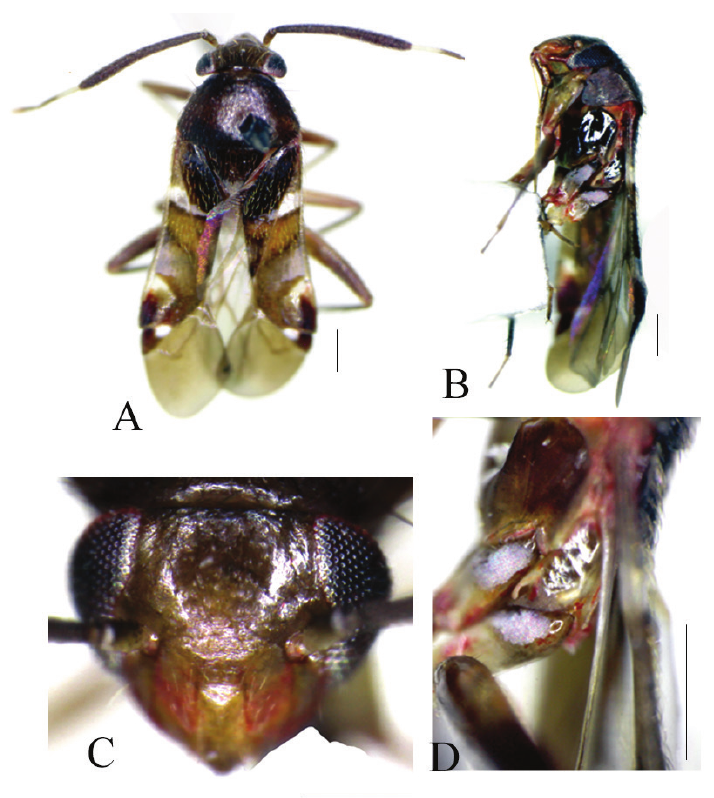
Figure 1. Habitus images of Biromiris tomokunii , holotype male. A dorsal view B lateral view C Head in frontal view D Scent gland evaporatory area. Scale bars, 0.5